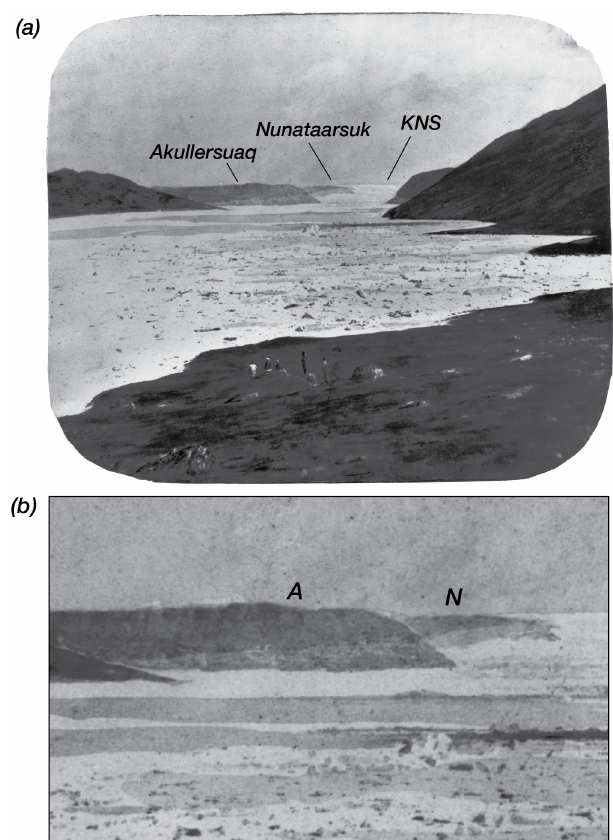
Figure 10. (a) Photograph looking up-fjord towards KNS taken some time in the 1850s by Danish geologist Hinrich Rink (Weidick et al., 2012). Our northeastern KNS field site (Fig. 9) is located on the distal side of Nunaatarsuk. (b) Close-up of Akullersuaq (A) and Nunaatarsuk (N) that captures the trimline marking the historical maximum extent of KNS. The photograph is housed in the archives of the National Museum in Copenhagen. A digital copy was gra- ciously provided by O.